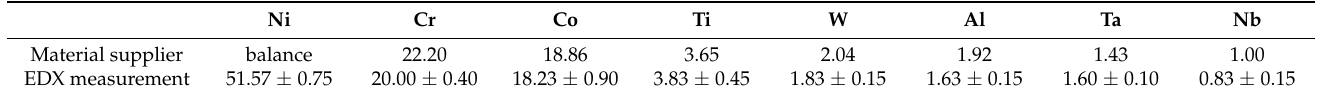
Table 1. Material supplier specification and EDX measurement of chemical composition of virgin IN939 powder in weight percentage (wt. %).